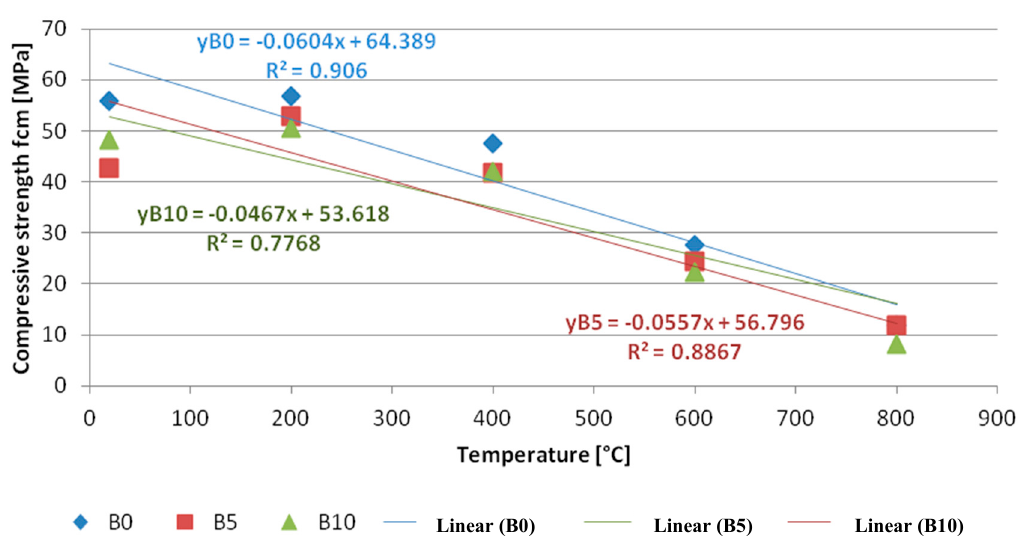
Figure 12. Correlation between the average compressive strength and temperature of heated concrete B0, B5, B10.